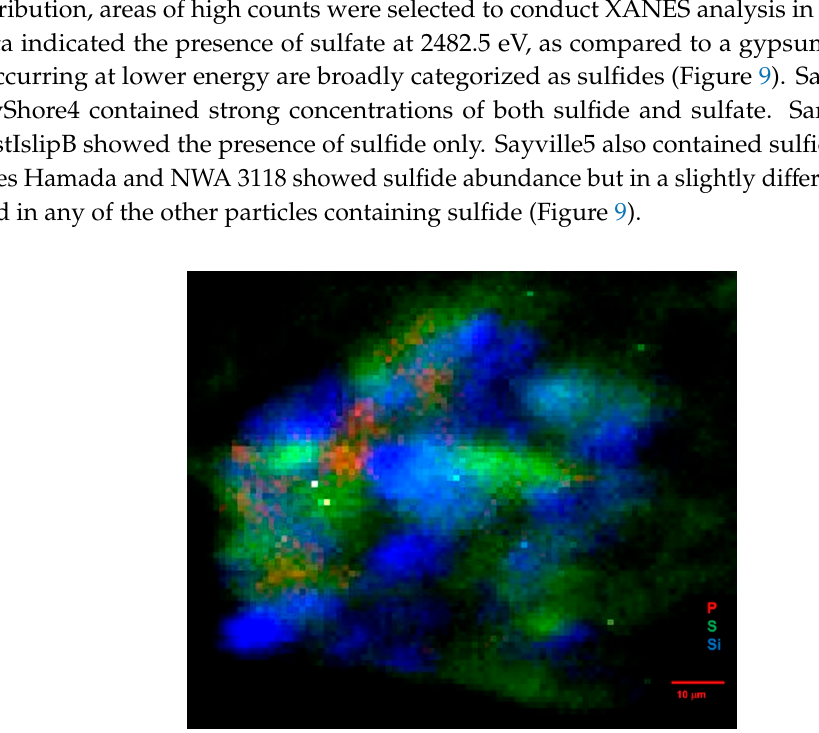
Figure 7. Complete XRF image of cosmic spherule BayShore3; this tricolor map shows P (red), S (green), and Si (blue). Note the elements are distributed heterogeneously throughout the particle.